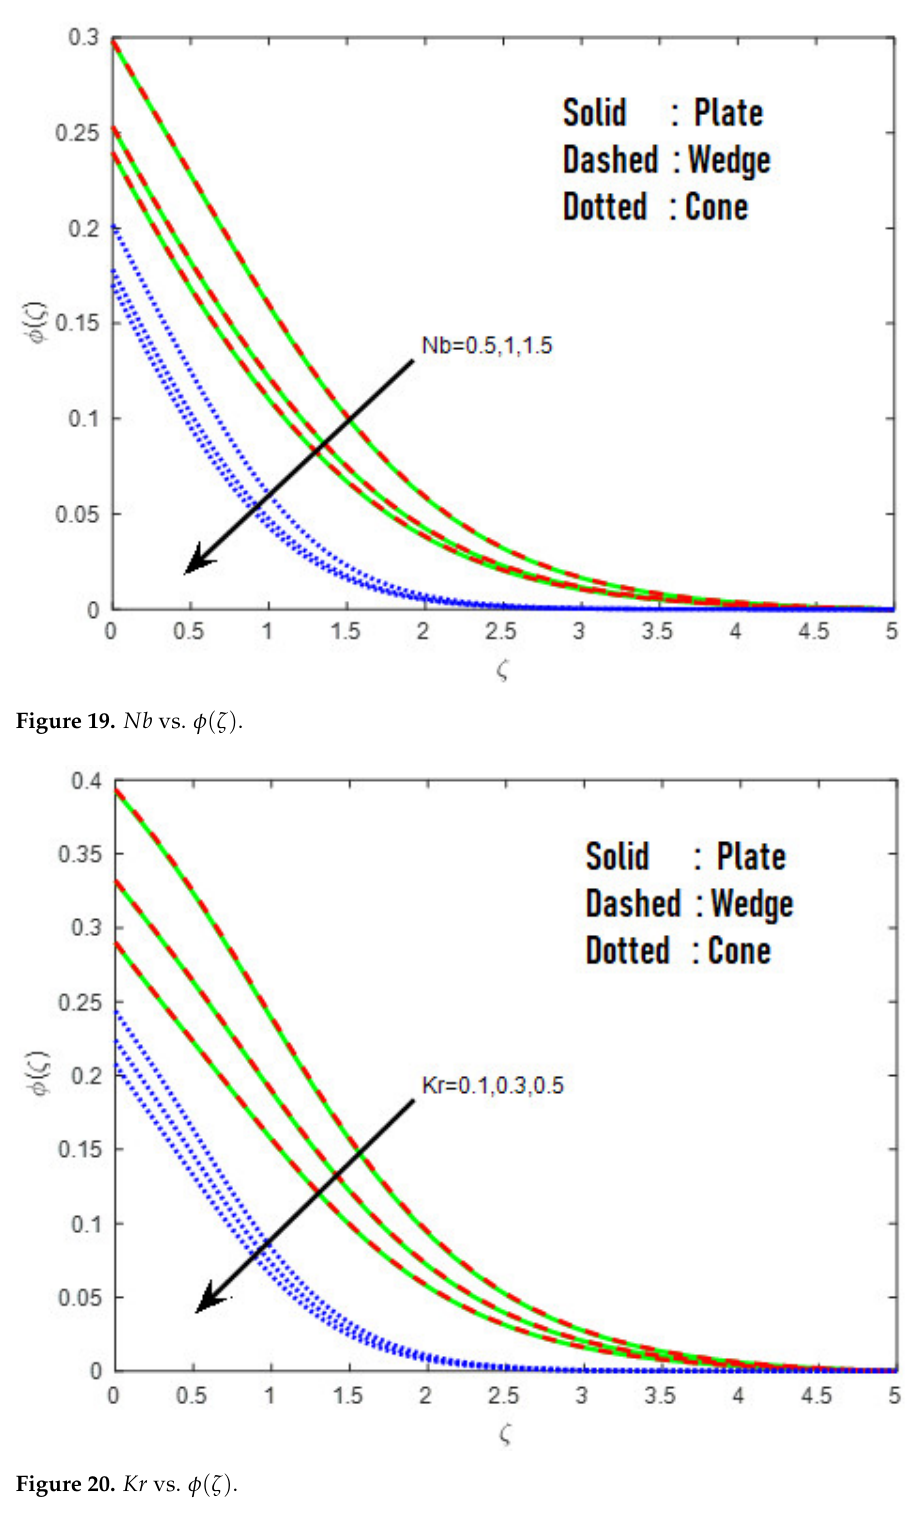
Figure 20. Kr vs.